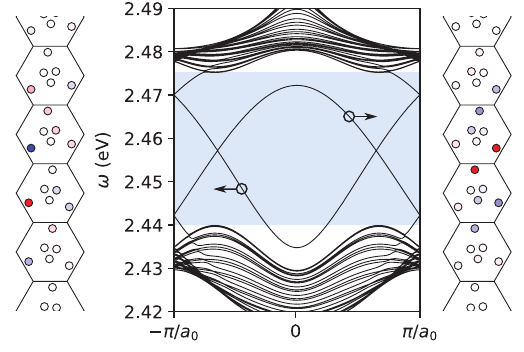
, type I edge. Figure 4: C 3 v The top and bottom media are perturbed by θ = ± 0.1 rad. Band structure for the edge states. The dipole moments of the edge states circled are shown either side, demonstrating the confinement to the edge.